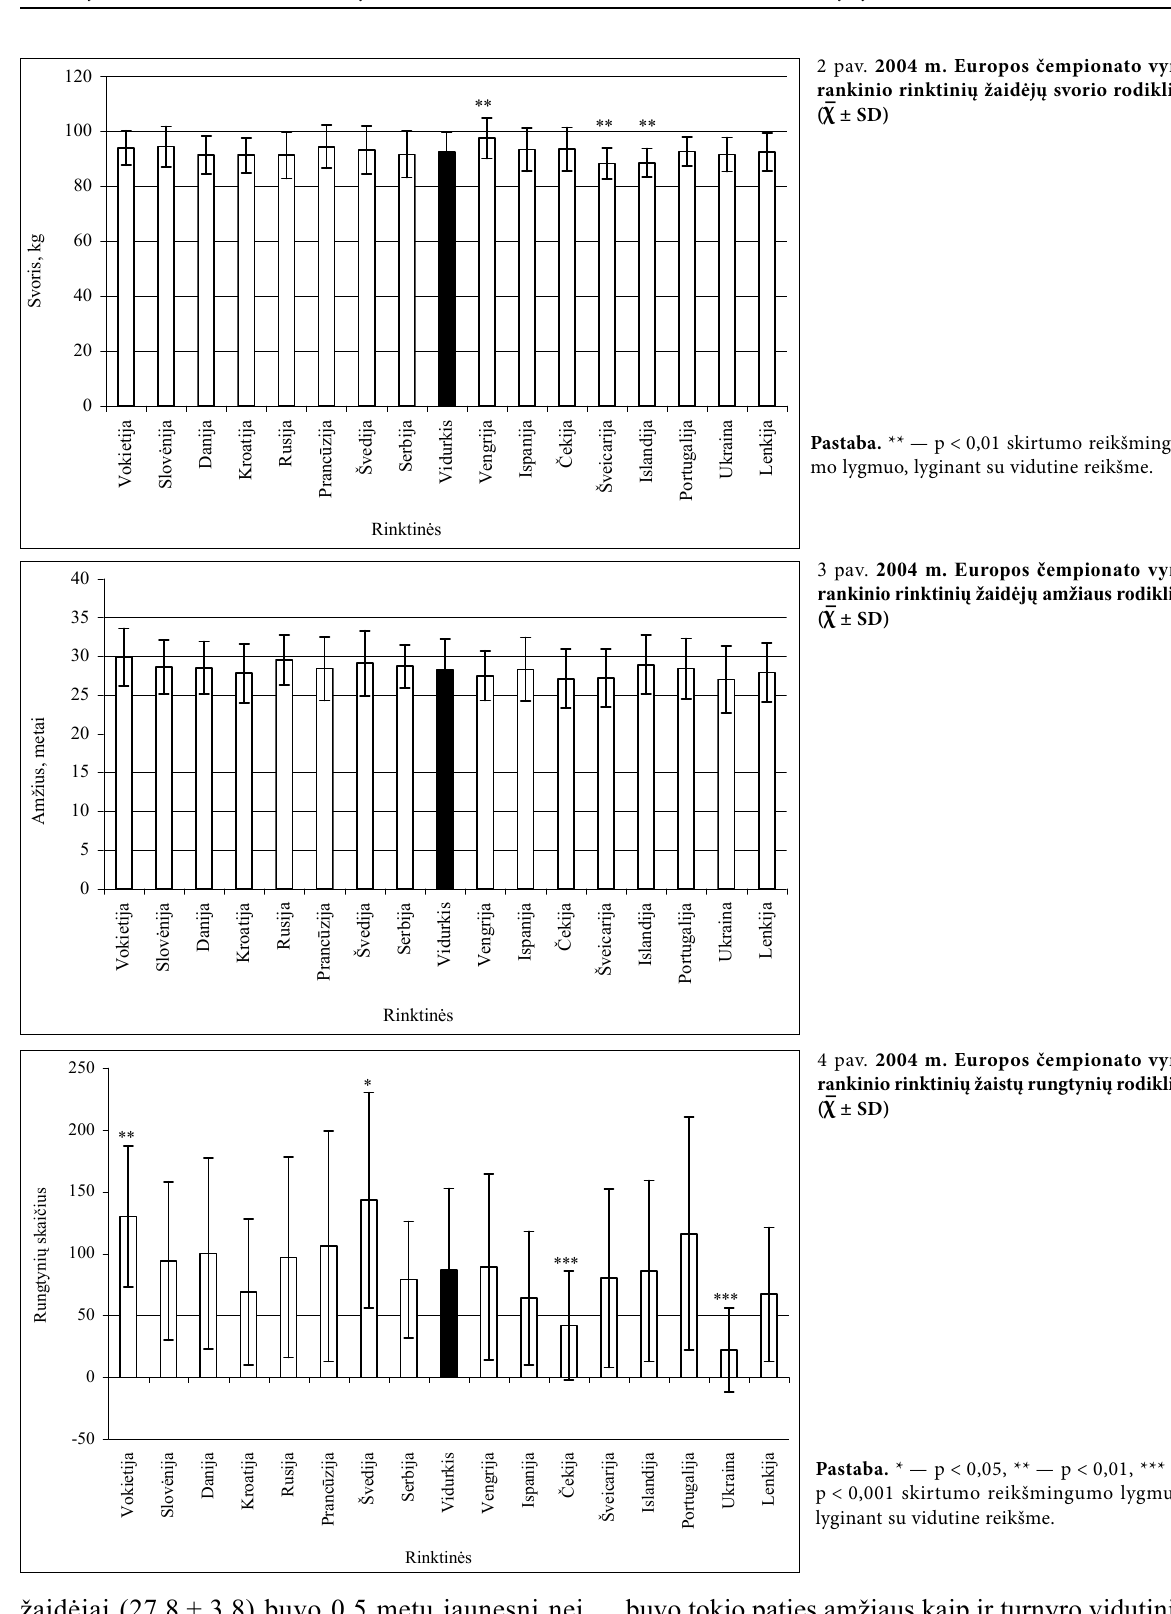
rink tin ė je. Č empionato dalyvis rinktin ė je